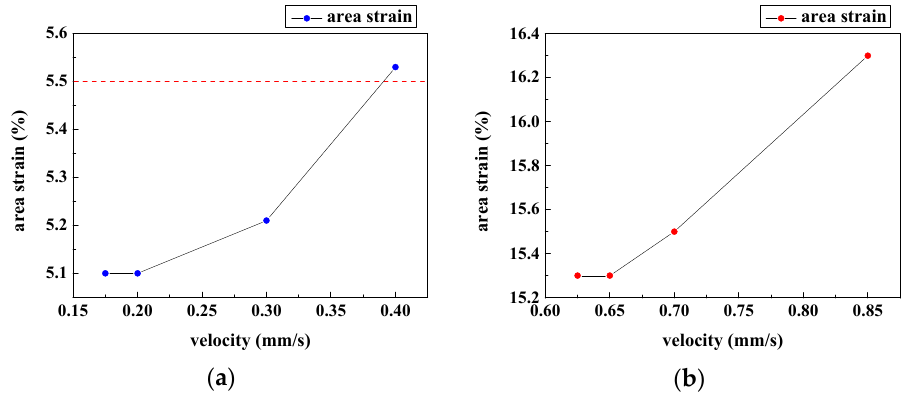
Figure 3. Membrane area strain of white blood cells (WBCs) at various inlet velocities: ( a ) area strain of WBCs passing through the microfilter with slit-shaped pores; ( b ) area strain of WBCs passing through the microfilter with circular pores.